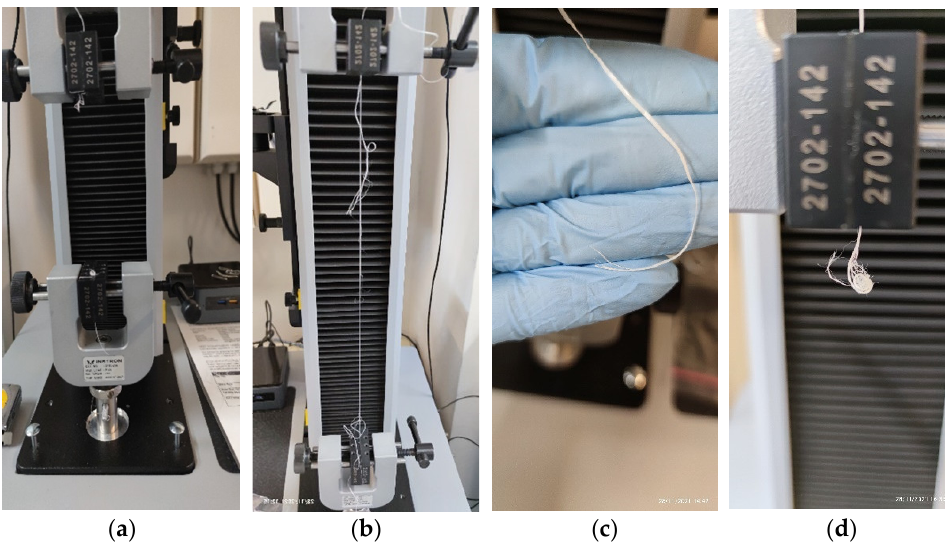
Figure 5. Breakage patterns of Lacalut ( a ), Oral B Essential ( b ), Oral B Satin ( c ), and Sensodyne ( d